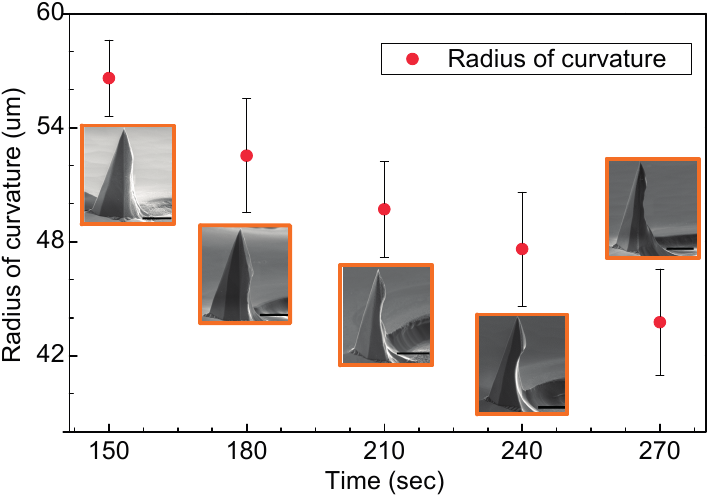
Figure 7. Radius of barb curvature at various etching times (HF/HNO The scale bar is 20 μ m.